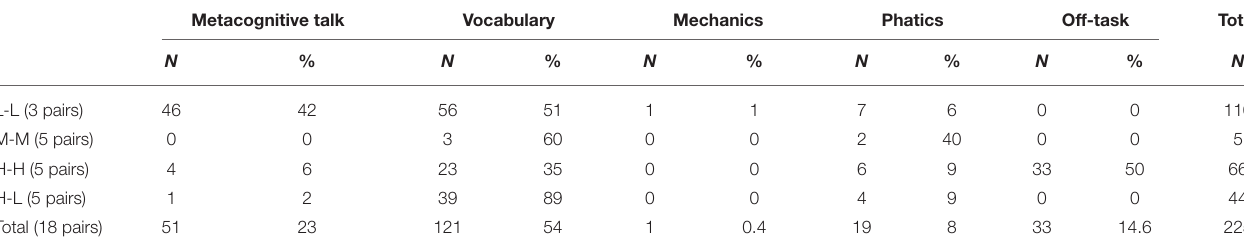
TABLE 8 | The frequency and percentage of L1 functions per proficiency pairing.